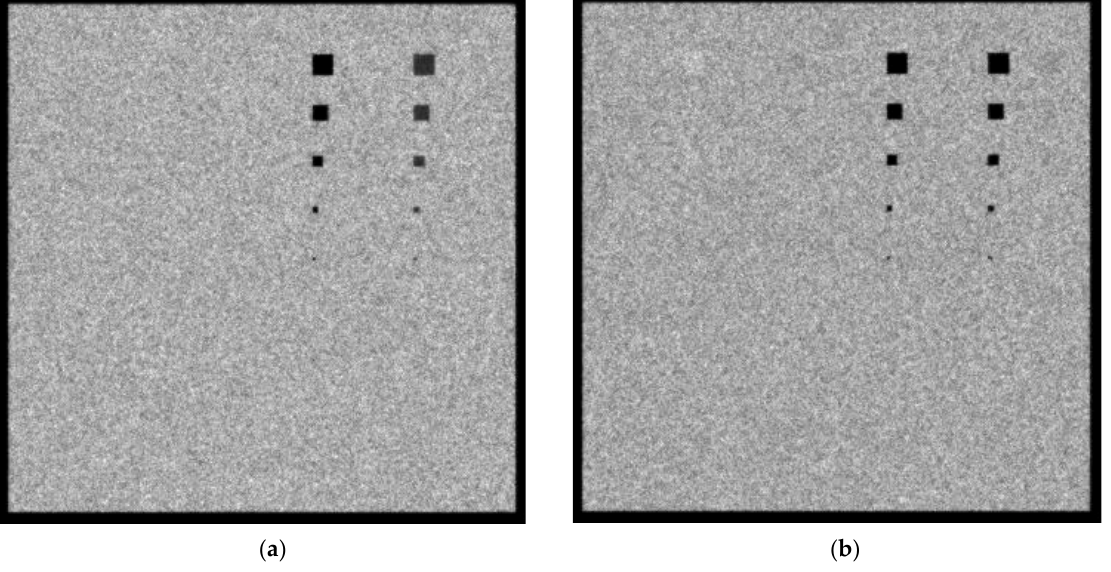
Figure 10. A 6 cm phantom image for Mo/Mo 3 mGy and 32 kVp spectrum with ( a ) 0.1 cm lesion thickness and ( b ) 0.5 cm lesion thickness.